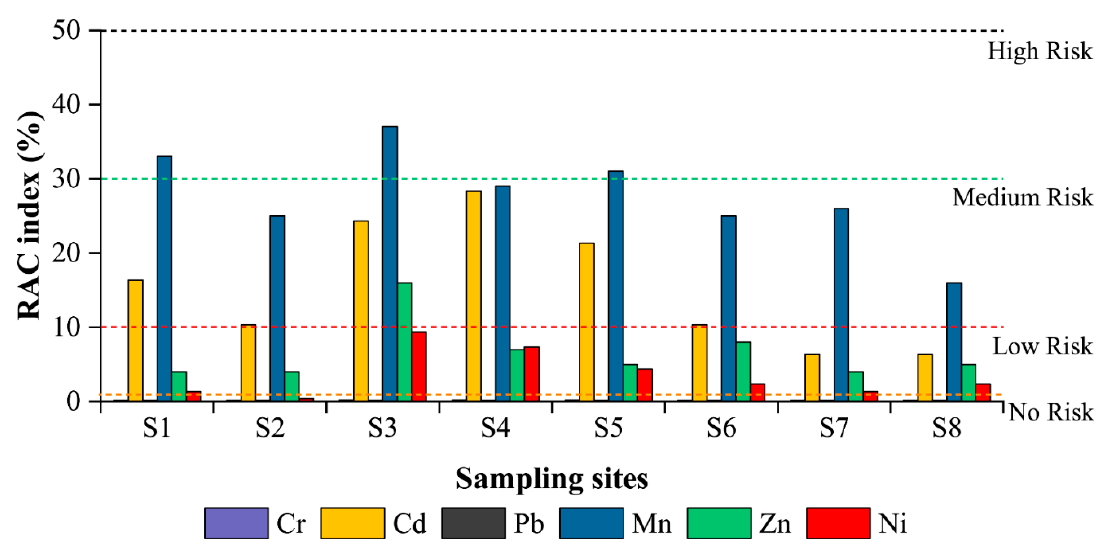
Figure 8. Level of RAC for heavy metals in study area.